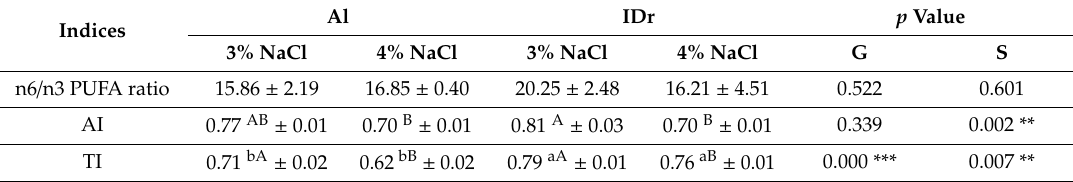
Table 3. Nutritional indices for Catalão samples according to genotype and salt content.